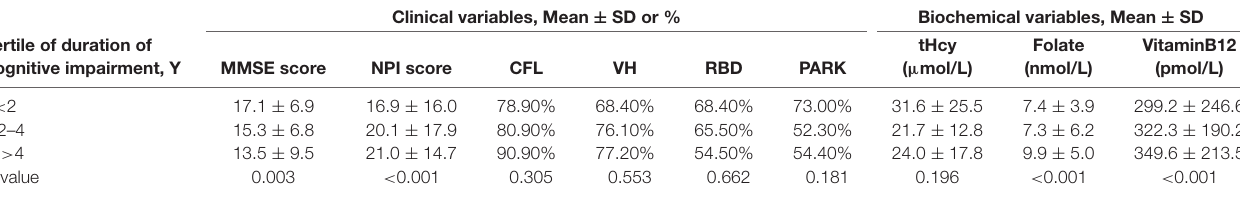
TABLE 3 | Clinical and biomedical variables in DLB patients by the duration of cognitive impairment at